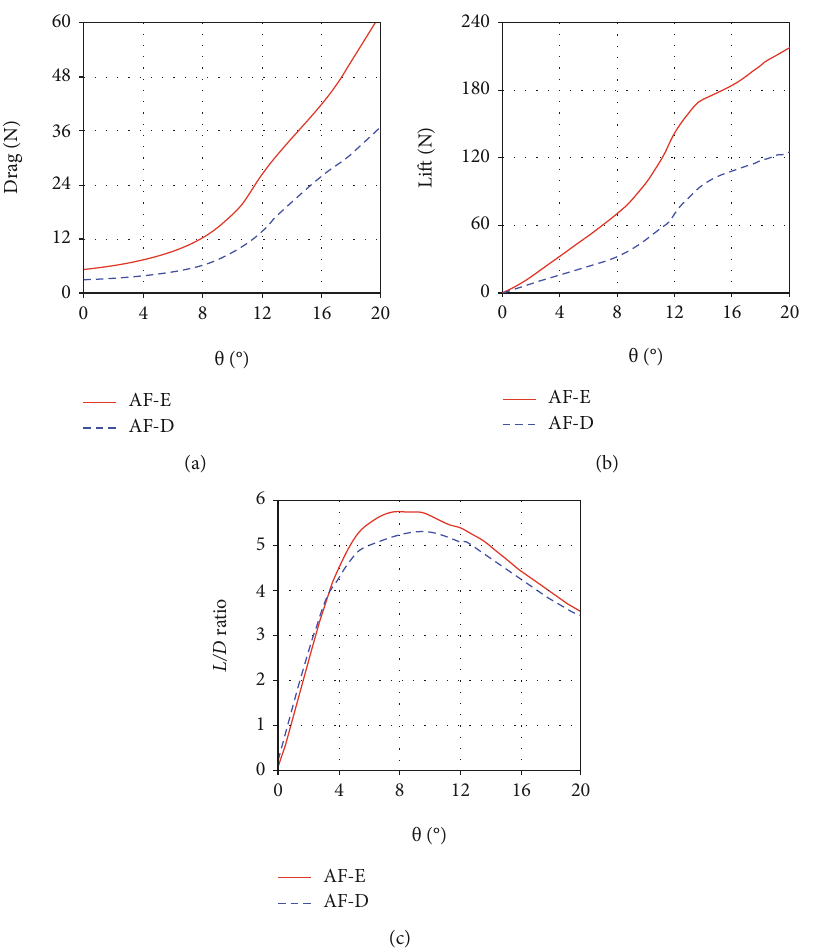
Figure 4: The drag, lift, and L / D ratio of the anal fi n (AF) in the erection and depression states under the quasi-static yaw motion ( ω = 0 : 01 rad/s): (a) the drag of the anal fi n; (b) the lift of the anal fi n; (c) the L / D ratio of the anal fi n. Note: AF-E (or AF-D) represents the erection (or depression) state of the anal fi